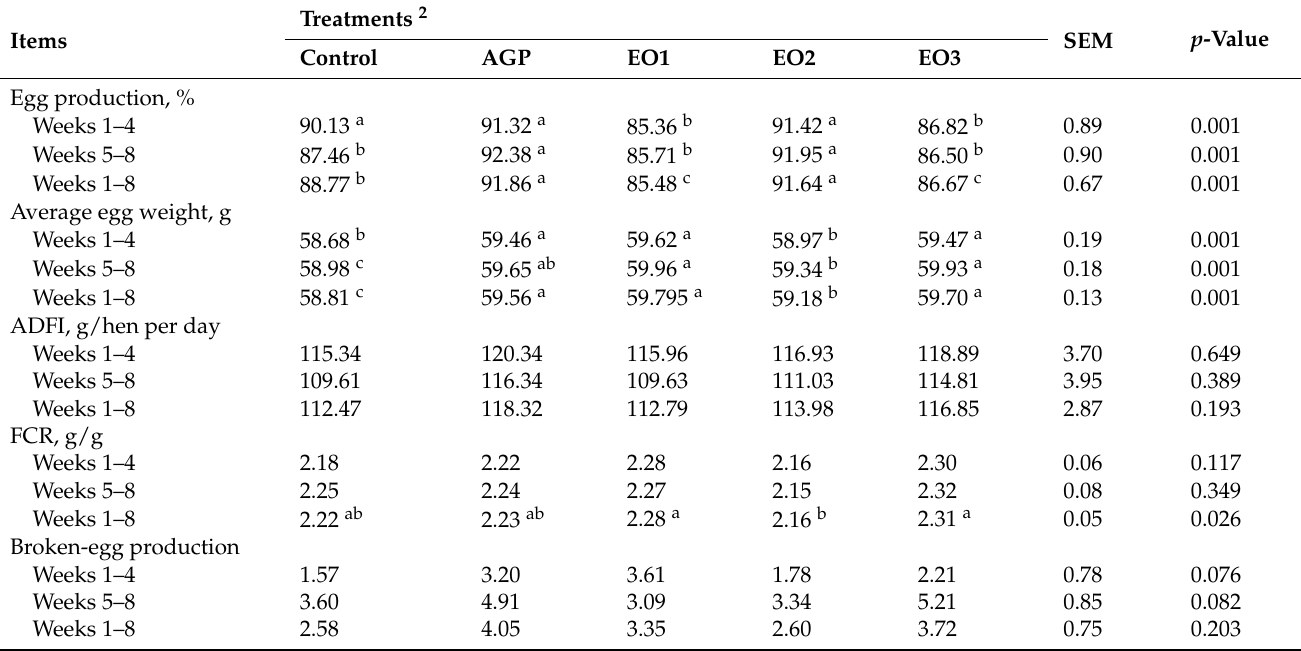
Table 2. Effects of dietary supplementation with oregano essential oil on laying performance of laying hens 1